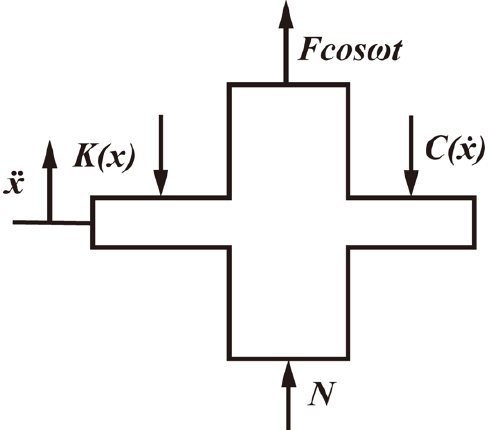
Figure 3. Equivalent mechanical model of the GMA output rod.